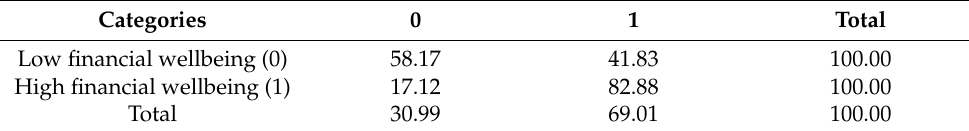
Table 6. Transition probabilities from one period to the next for financial